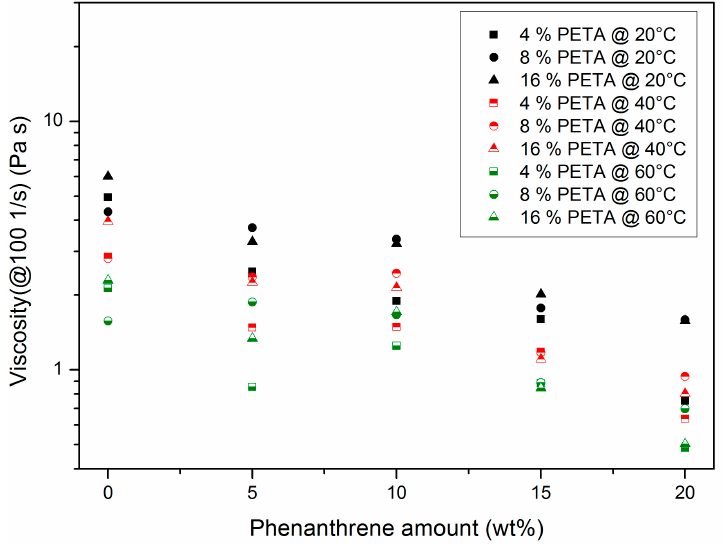
Figure 4. Influence of temperature, PETA, and phenanthrene content on the viscosity of the mixture at a common shear rate of 100 1/s.